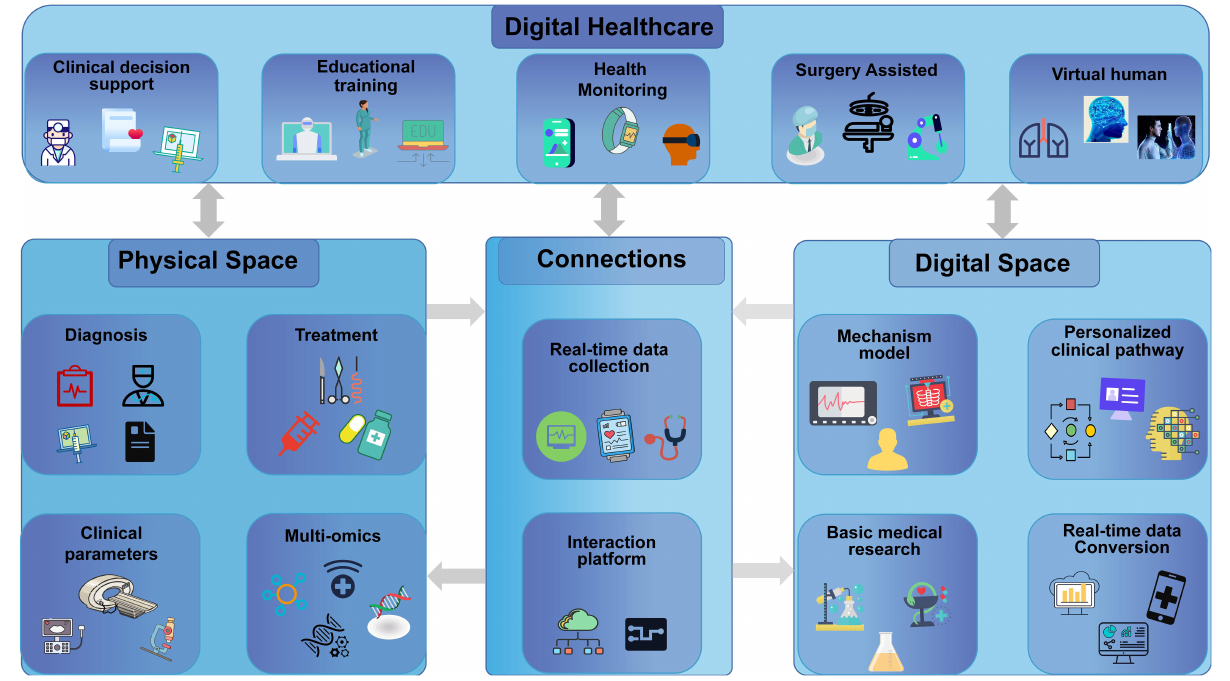
Frontiers in Medicine |